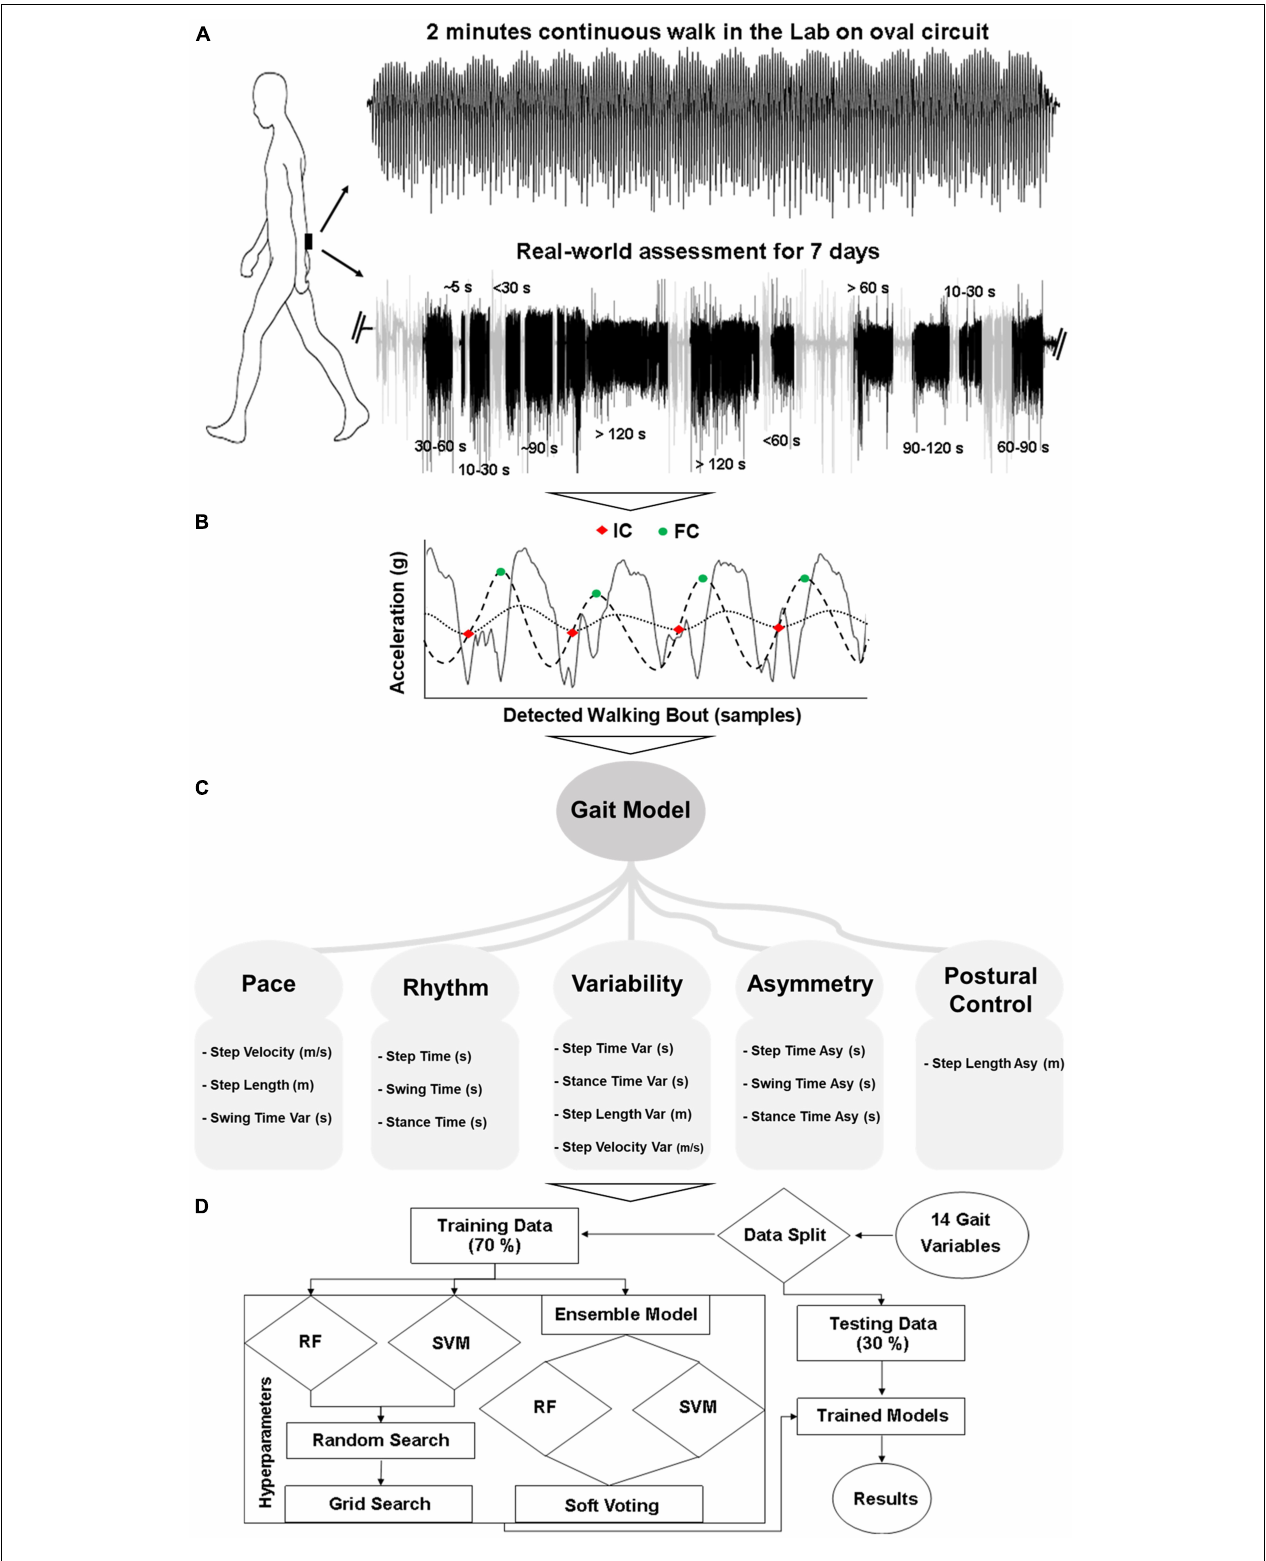
FIGURE 1 | Overall workflow from gait assessment to classification: (A) Gait assessment protocol, (B) WB detection and gait characterization, (C) 14 gait characteristics (Var, variability; Asy, asymmetry), (D) Classification modeling.